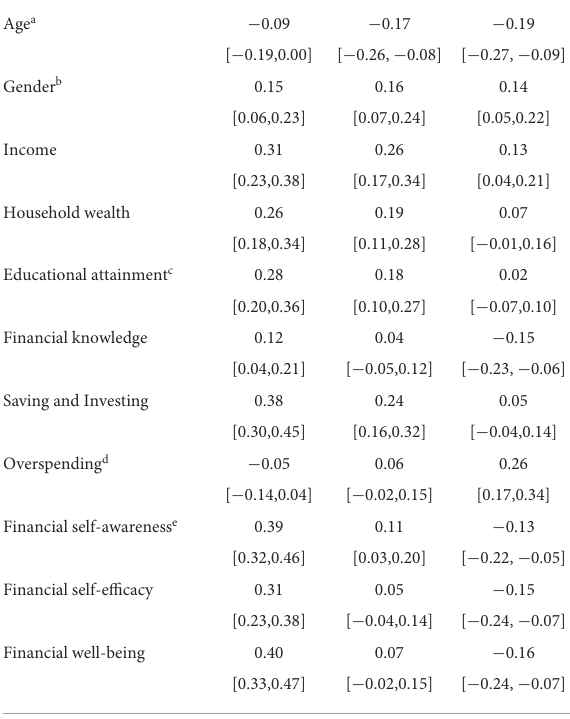
TABLE 5 Study 1 correlations of SDT financial motivations ( N =